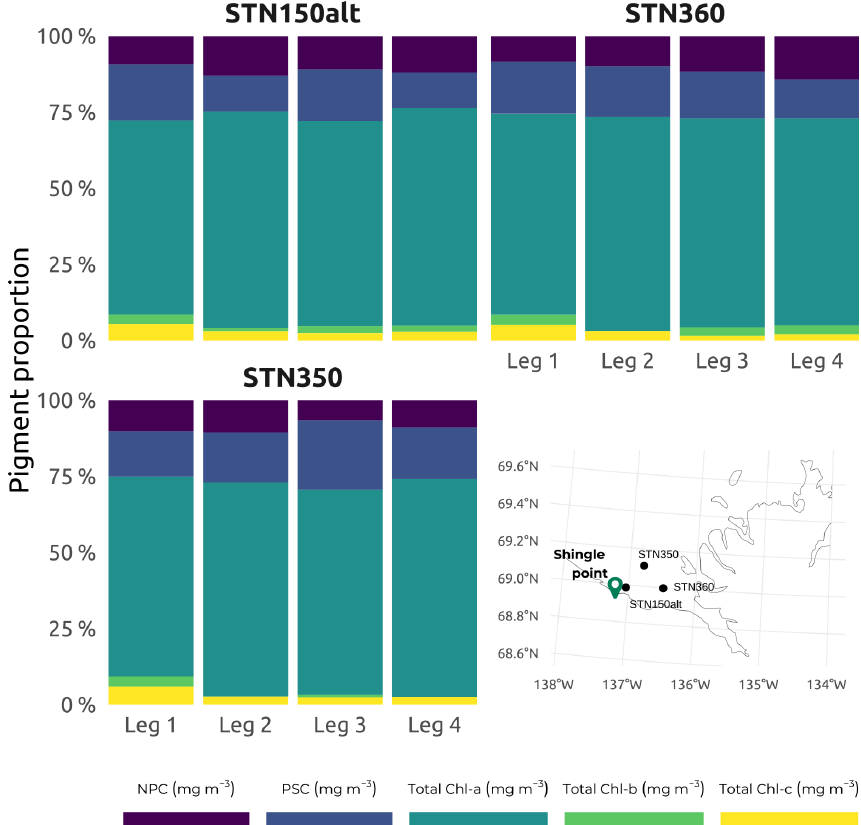
Figure 11. Subset of accessory pigments, classified following Matsuoka et al. (2011), namely non-photosynthetic carotenoids (NPCs) that include zeaxanthin, diadinoxanthin, and alloxanthin and photosynthetic carotenoids (PSCs) that include fucoxanthin, peridinin, 19 (cid:48) - hexanoyloxyfucoxanthin, and 19 (cid:48) -butanoyloxyfucoxanthin. Total Chl a , total Chl b , and total Chl c ( c 1 , c 2 , and c 3 ) are shown for the three selected stations (150ALT, 360, and 350) visited on each of the four WP4 Nunataryuk expeditions (Legs 1, 2, 3, and 4) in 2019. Also included is a map showing the locations of the three stations in the western sector of Mackenzie